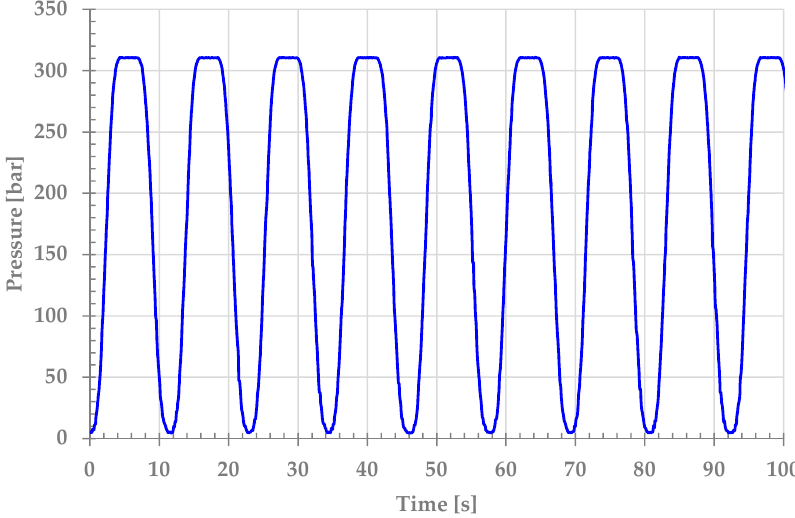
Figure 10. Test spectrum of impulse fatigue.